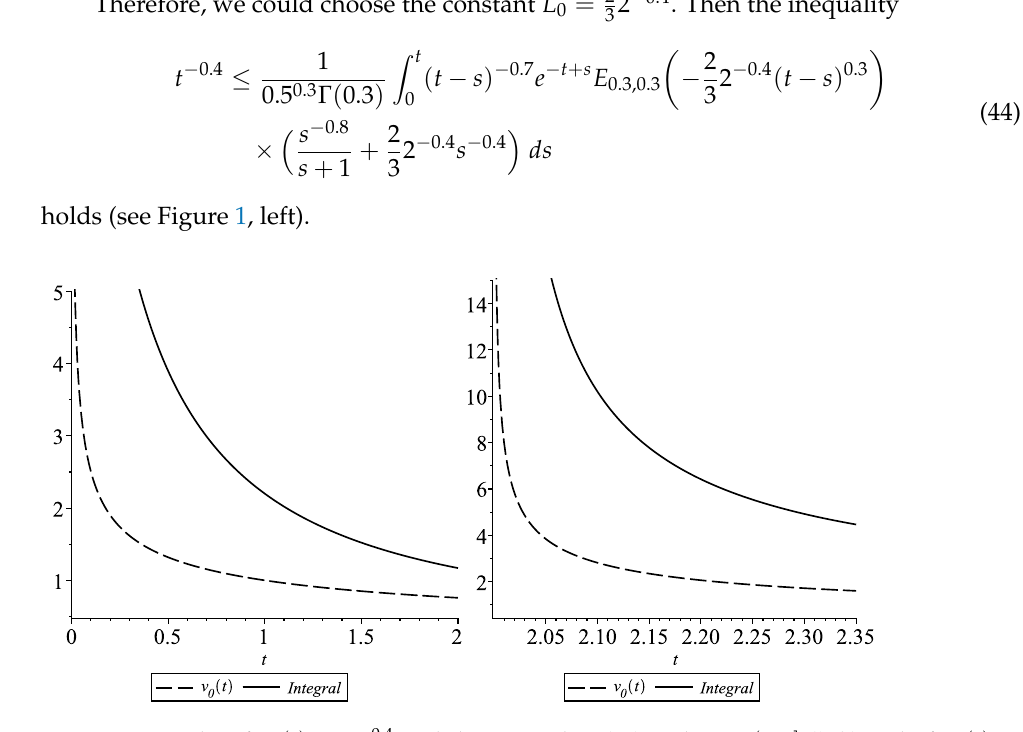
( 0,2 ] ( left ) and of v 0 ( t ) = ( 0,2 ] (left) and of v 0 ( t ) = ∈ ∈